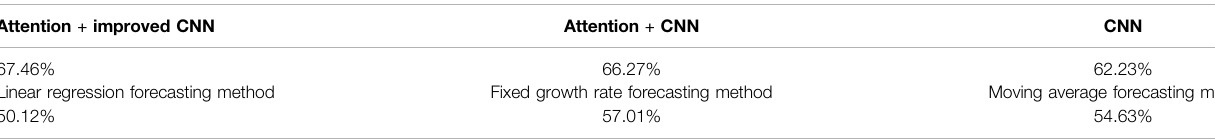
TABLE 1 | The load trend judgment accuracy of various methods.